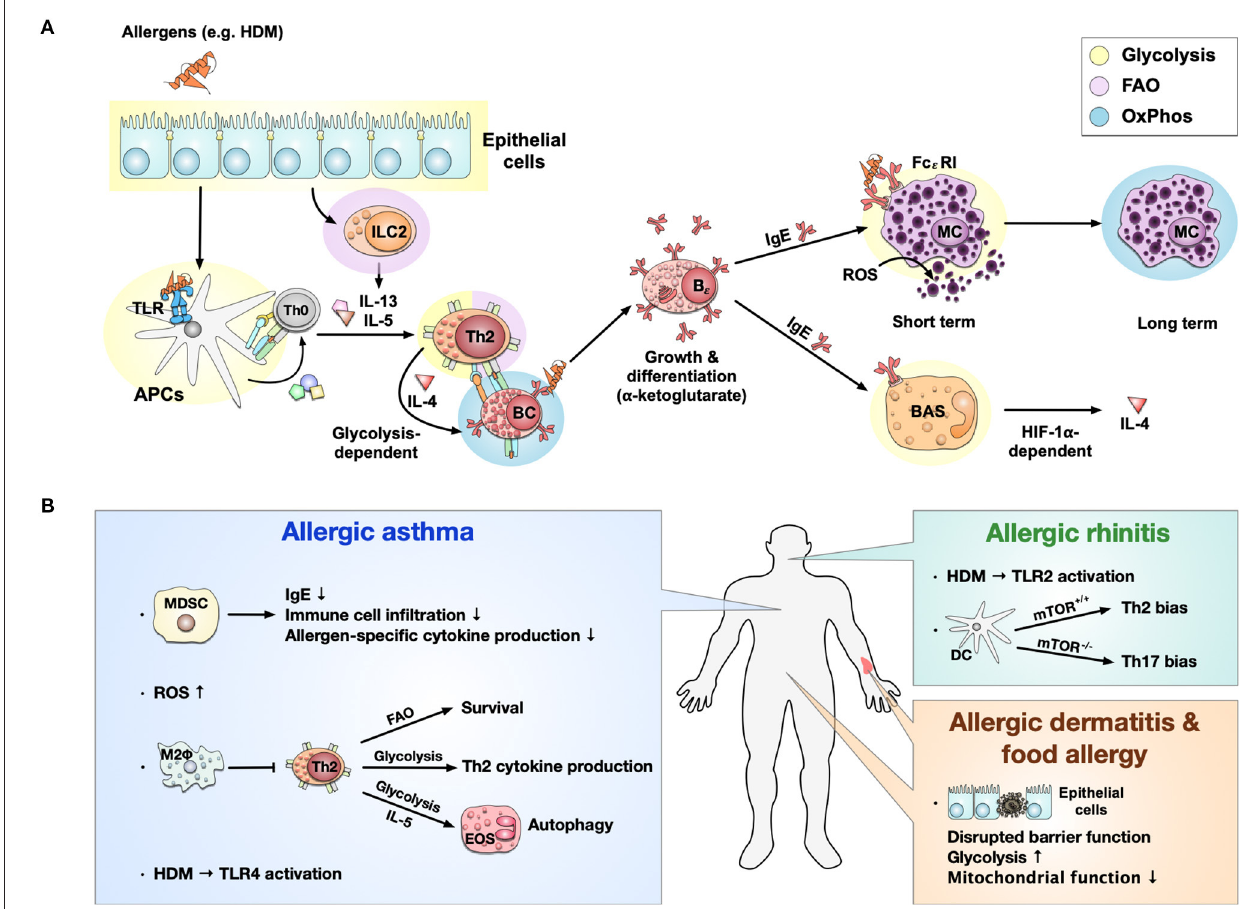
FIGURE 3 | Immune metabolism in allergies. Immune metabolism in allergic sensitization and pathology (A) . Allergens, e.g., derived from house dust mites (HDM), activate epithelial cells and induce a metabolic shift toward glycolysis. Epithelial cells further activate ILC2s and induce FAO-dependent production of the Th2 cytokines IL-5 and IL-13. Some allergens can also bind to TLRs, causing a switch from OxPhos to glycolysis in APCs. Activated ILC2s and APCs further induce the differentiation of naïve T cells into Th2 cells which produce IL-4 in a glycolysis-dependent manner. The activation and differentiation of B cells into IgE-producing plasma cells after IL-4 stimulation is dependent on the Krebs cycle-derived metabolite α -ketoglutarate. The produced IgE binds to the high-affinity FC ε RI on mast cells, where cross-linking of IgE leads to a short-term glycolytic phenotype. In contrast, long-term mast cell activation is dependent on OxPhos. Additionally, high concentrations of ROS can directly activate mast cells to release histamine and serotonin. On the other hand, IgE can also bind to basophils, leading to a HIF-1 α -dependent activation of glycolysis and subsequent IL-4 production. Immune metabolic changes observed in allergic asthma, rhinitis, dermatitis, and food allergy (B) . In allergic asthma, MDSCs have been shown to inhibit allergic asthma by reducing IgE production, immune cell infiltration, and allergen-specific cytokine production. At the same time, high levels of reactive oxygen species (ROS) were found. OxPhos-based anti-inflammatory M2 macrophages may locally inhibit Th2 responses in allergic asthma. Furthermore, for Th2 cells, FAO-dependency could be identified to be essential for survival, while glycolysis was essential for Th2 cytokine production. IL-5 can activate eosinophils, shift their metabolism toward a glycolytic phenotype, and affect their effector functions like autophagy in asthma. Allergic asthma induced by HDM was shown to be TLR4-dependent; while HDM-induced allergic rhinitis was driven by TLR2 activation. In allergic rhinitis, mTOR-deficiency in CD11b + DCs induced Th17- instead of Th2-biased immune responses. While little is known about immune metabolism in allergic dermatitis and food allergy, they are both connected to a disrupted barrier function of epithelial cells characterized by a predominantly glycolytic phenotype and mitochondrial dysfunction. TLR, “Toll”-like receptor; APC, antigen presenting cell; MC, mast cell; BAS, basophil; ROS, reactive oxygen species; HIF-1 α , hypoxia inducible factor 1 alpha; MHC, major histocompatibility complex; mTOR, mammalian target of rapamycin; FAO, fatty acid oxidation; HDM, house dust mite; IgE, Immunoglobulin E; B ǫ , IgE-producing B cell; BC, B cell; TC, T cell; OxPhos, oxidative phosphorylation; MDSC, Myeloid-derived suppressor cell; Fc ε RI, fragment crystallizable region epsilon receptor I; M2 Φ , M2-macrophages; EOS, eosinophils.